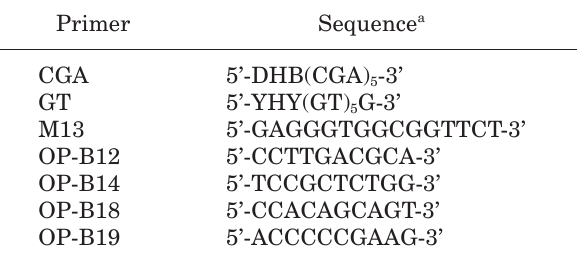
Table 2. Details of primers used in this study.